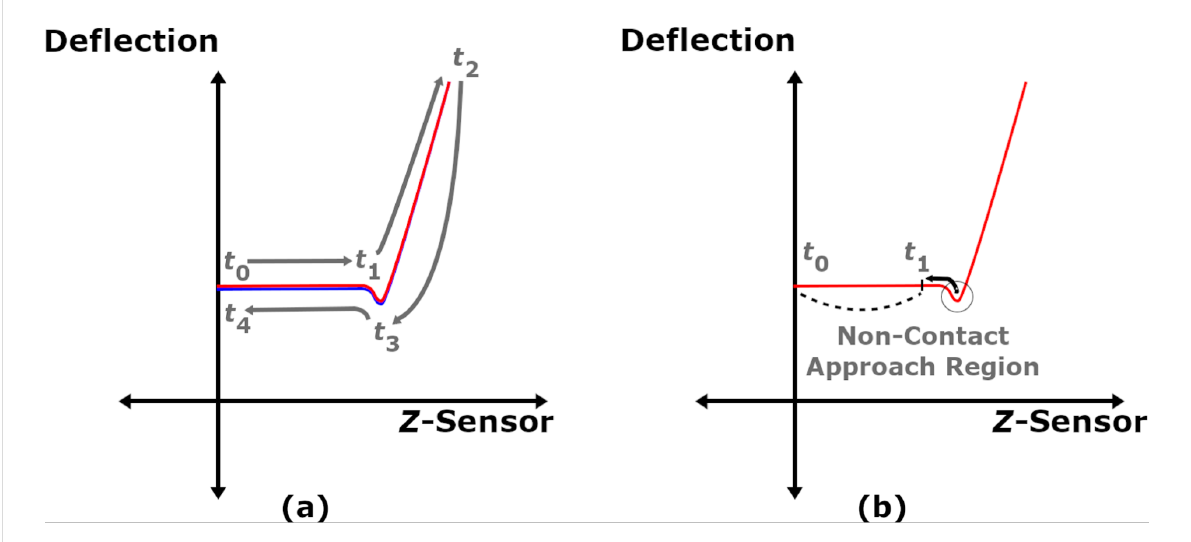
Figure 2: (a) A raw AFM-SFS dataset; (b) approach portion from the raw curve.